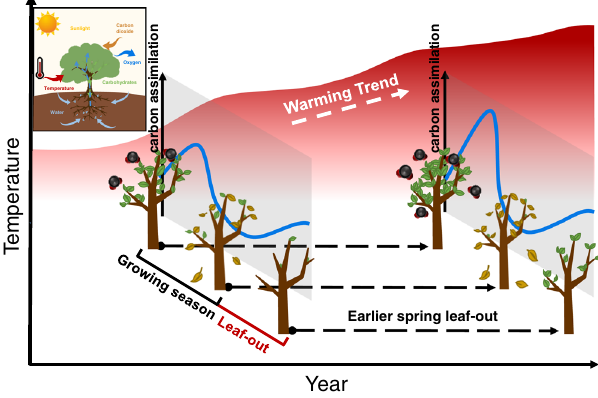
Fig. 5 Relative in fl uence of GPP max and climatic factors during previous growing season on start of season (SOS) of current year using the data of 28 FLUXNET sites between 1992 and 2014. The GPP max refers to the maximum daily gross primary productivity (GPP) in each year. Random- forest algorithm was used to quantify and compare the effects of climate variables and GPP max on SOS.